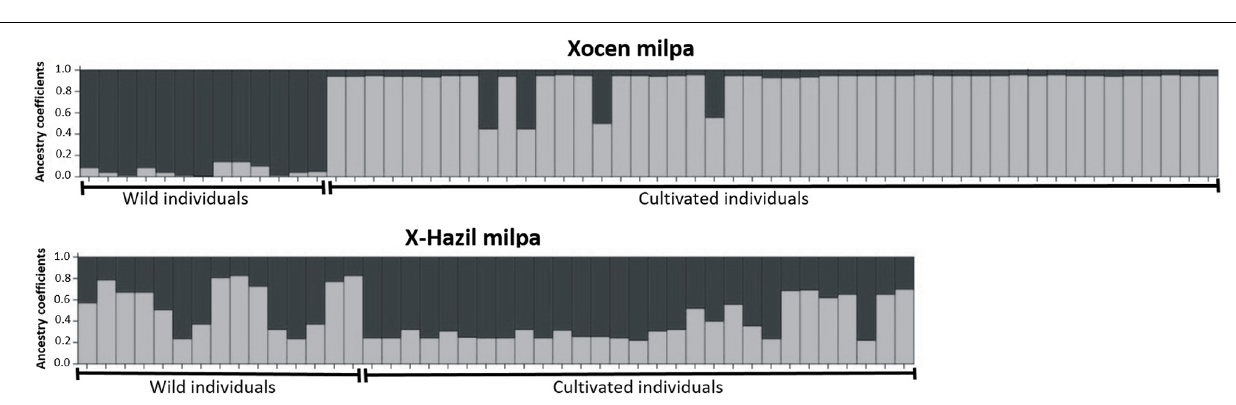
FIGURE 10 | Coefficients of estimated ancestry of wild and cultivated individuals of Lima beans growing sympatrically in two milpas from Yucatan (Xocen milpa) and Quintana Roo (X-Hazil milpa), Mexico, using 12 microsatellite loci and the Structure program. Each individual is represented by a single vertical line broken into two colored segments, with lengths proportional to the individual’s estimated ancestry fraction from each of the two biological statuses. Modified from Dzul-Tejero et al.